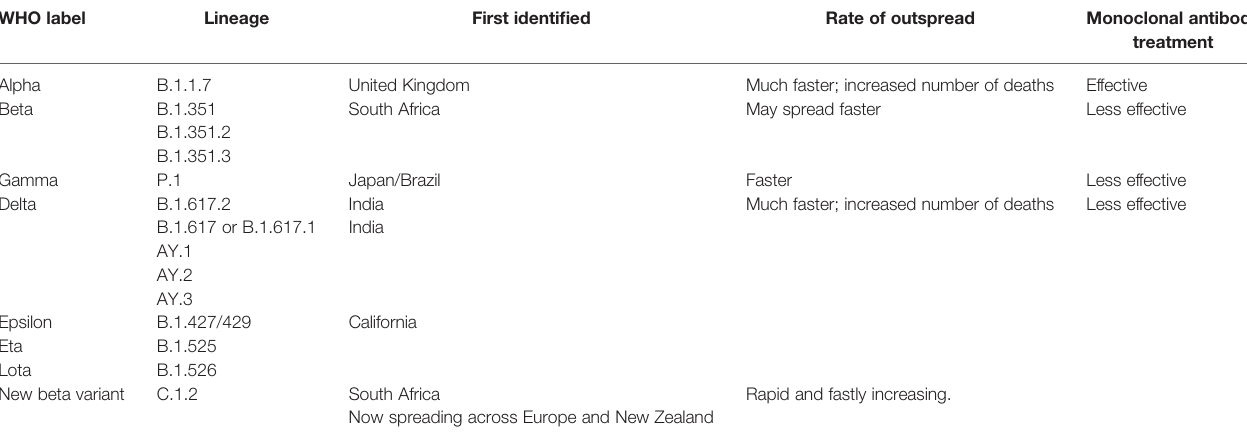
TABLE 2 | List of known COVID-19 variants of concern (6, 55, 59 – 74, 90 –